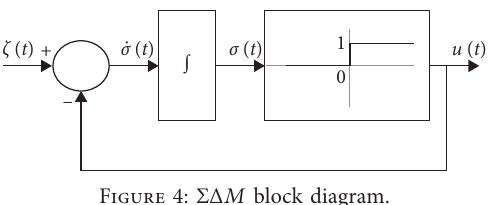
Figure 4: ΣΔ M block